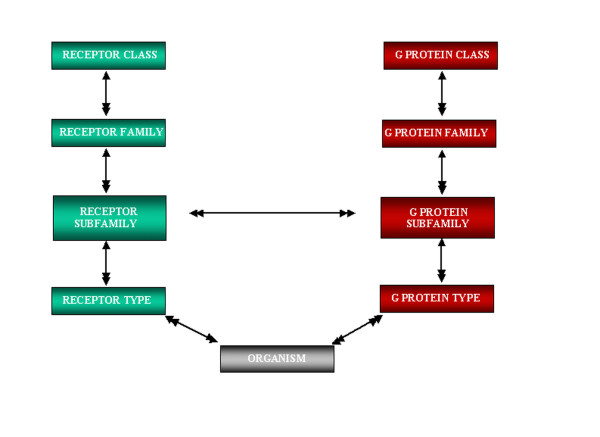
The Relational Scheme of the database Single-edged arrows indicate a "one-to-one" relation, whereas double-edged arrows indicate "one-to-many" relation. When there are double-edged arrows in both ends of a connection (for instance the Receptor subfamily – G protein type, interaction), this is an indication of relation of the type "many-to-many", i.e. a particular G protein may couple to receptors of different subfamilies, whereas a single receptor may couple to G proteins of different types.